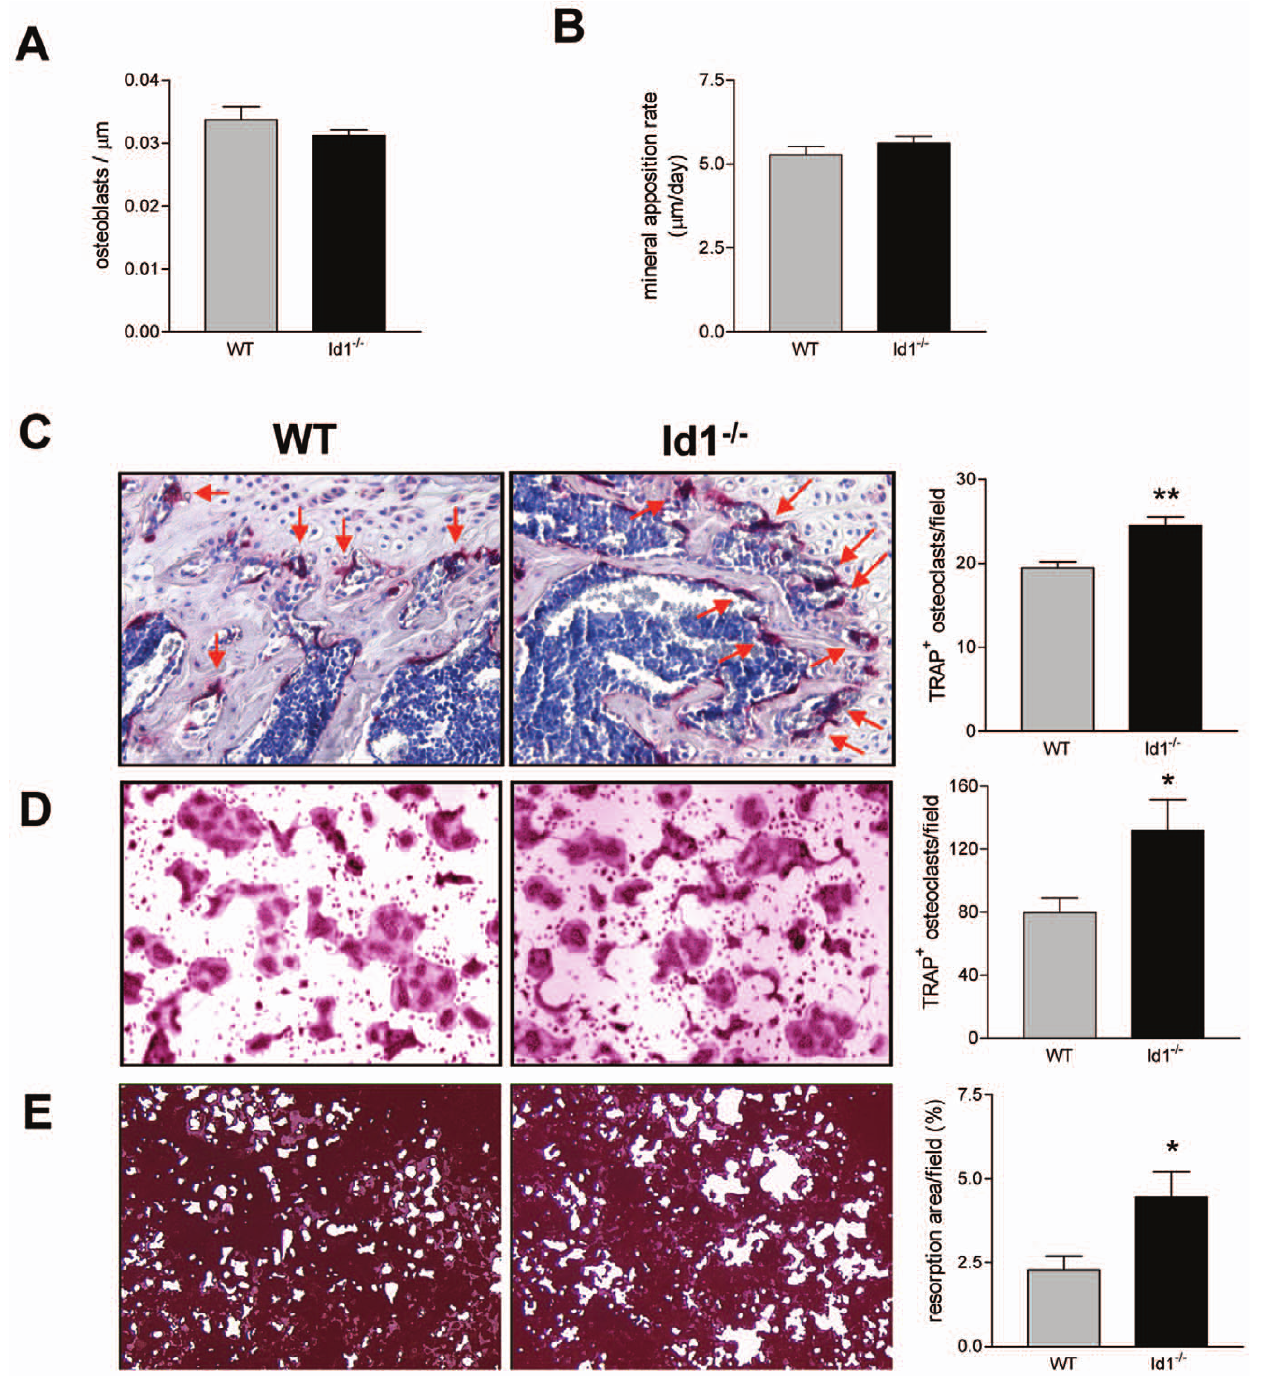
Figure 2. Enhanced osteoclast differentiation in Id1 2 / 2 mice. (A) Femoral sections were stained for Procollagen Type I and the number of osteoblasts per unit surface area was counted. (B) The mineral apposition rate was determined by double tetracycline labeling. (C) Enzyme histochemistry staining for TRAP on femoral sections (200X). Arrowheads indicate TRAP + osteoclasts stained in red. (D) BM cells were cultured in the presence of M-CSF and RANKL for 3 days and then subjected to TRAP staining (400X). (E) BM cells were plated on a BD BioCoat Osteologic slide and cultured in the presence of M-CSF and RANKL for 10 days. The area resorbed was visualized by von Kossa staining (40X). (A–E) *P , 0.05, **P , 0.01; n=5. Error bars represent 6 S.E.M. doi:10.1371/journal.pone.0007955.g002 remained unchanged (Figure S4). One of the cytokines that can be cleaved by CTSK is SCF, which is involved in anchoring stem protein level in the BM of Id1 2 / 2 mice as compared to wild-type littermates (Figure 5C,D). Expression levels of other cathepsins cells to the niche. Accordingly, we found elevated levels of SCF in